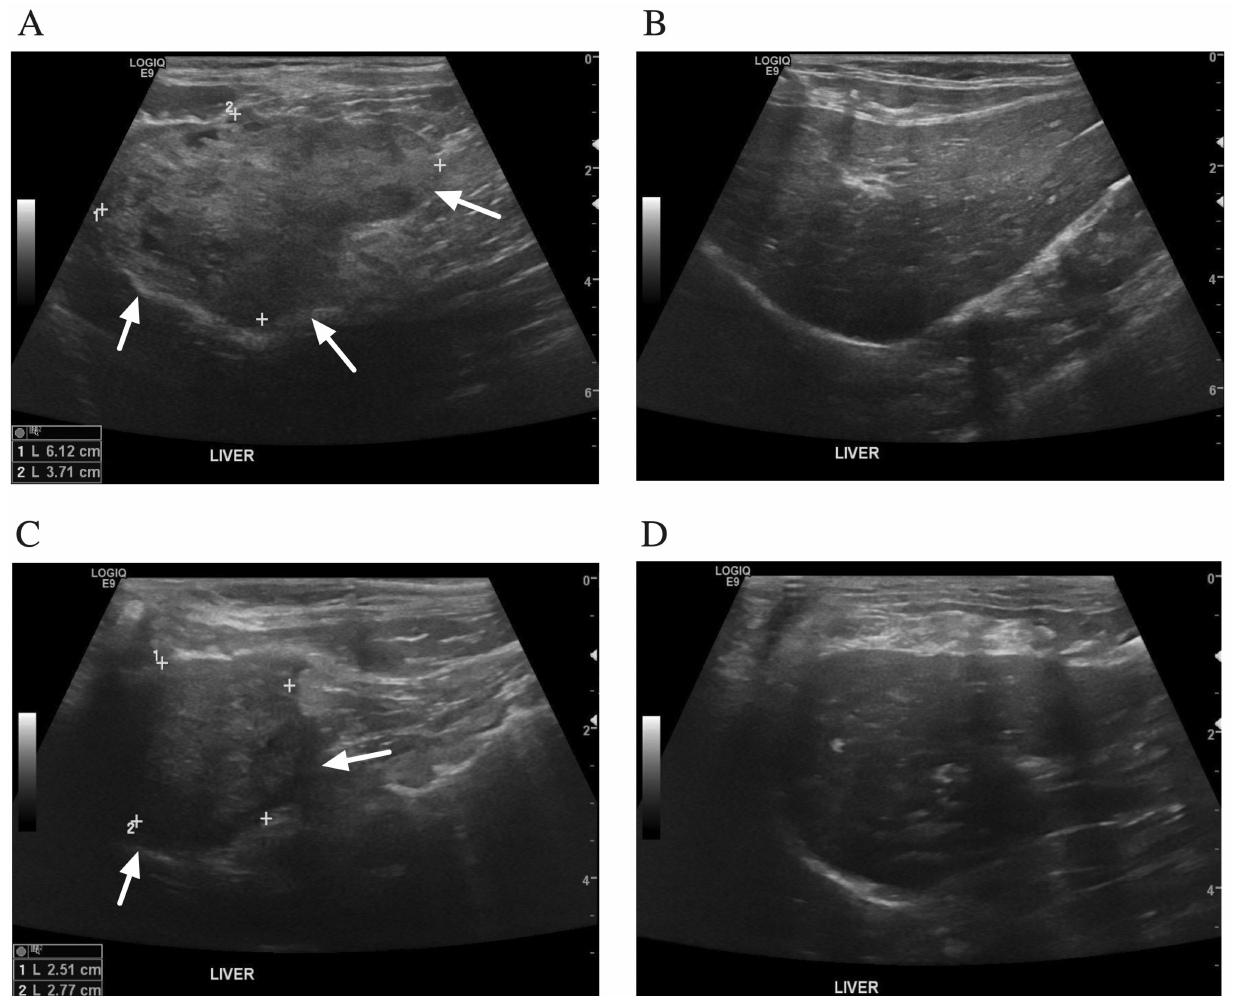
Figure 3. Ultrasonographic findings of the liver after treatment with prednisolone. ( A,B ) 12 weeks after prednisolone treatment. ( A ) The left lobe of liver showed a poorly defined mass (arrows) containing small irregular anechoic cavitations. ( B ) The right lobe of liver had a homogeneous parenchyma. There was no evidence of intrahepatic bile duct dilatation. ( C , D ) Twenty-three months after stopping prednisolone. ( C ) The left lobe of liver showed a heterogenous mass (arrows). ( D ) The right lobe of liver had a mild heterogenous parenchyma and round border. There was no evidence of common bile duct and intrahepatic bile duct